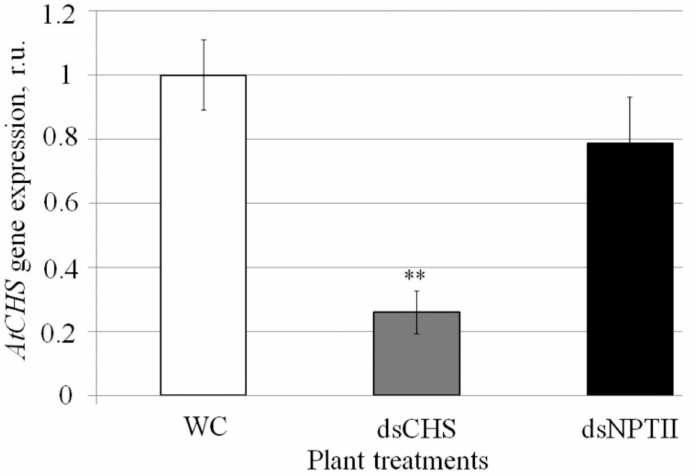
Figure 2. The effect of external AtCHS - and NPTII -encoding dsRNAs on AtCHS mRNA level in Arabidopsis thaliana analyzed by quantitative real-time PCR. WC— A. thaliana treated with sterile water; dsCHS— A. thaliana treated with AtCHS -dsRNA; dsNPTII— A. thaliana treated with NPTII - dsRNA; dpt—days post-treatment. A. thaliana plants were grown under anthocyanin-inducing (+7 ◦ C, 23 h light) conditions for two days after treatment with sterile water or synthetic dsRNA. qRT-PCR data are presented as the mean ± SE. **—significantly different from WC at p ≤ 0.01 according to Student’s t